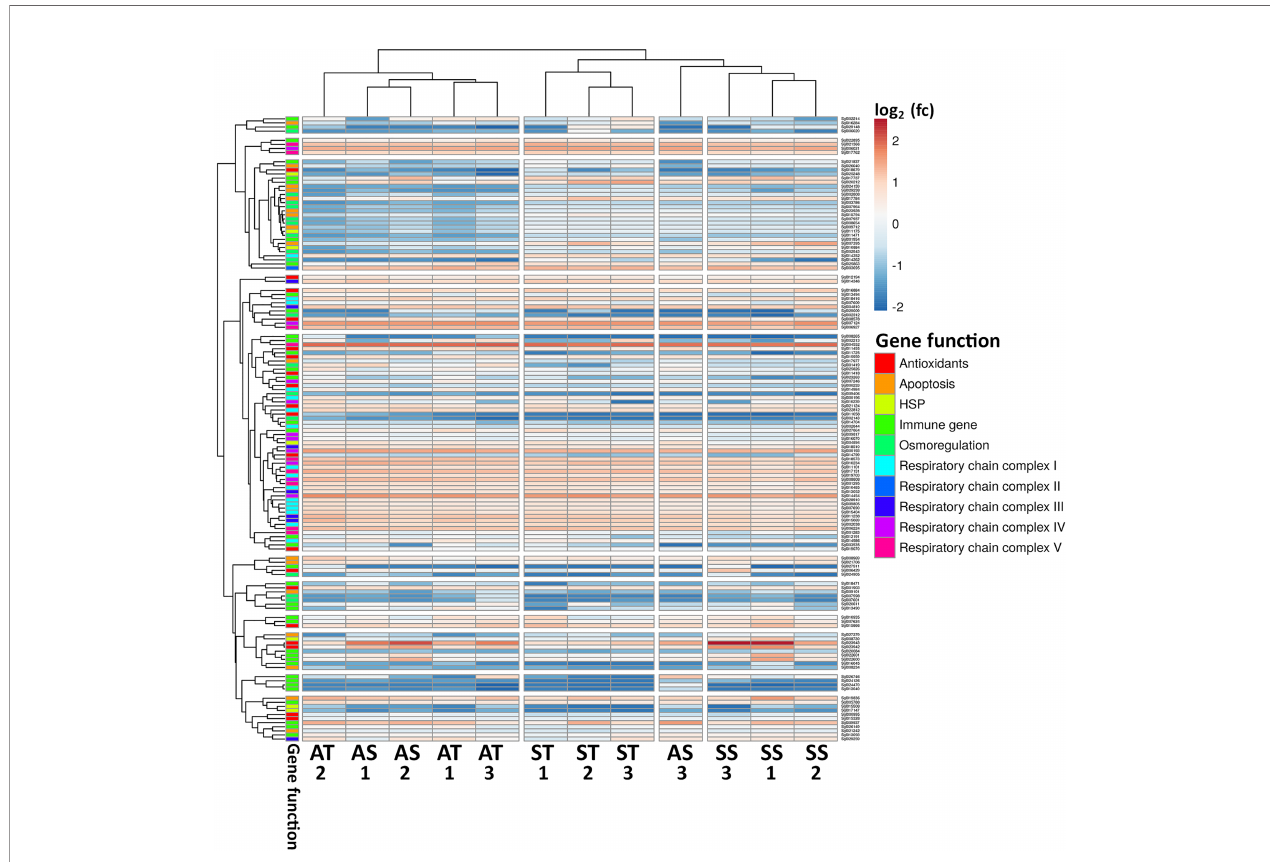
FIGURE 9 | Heatmap showing DGE of genes of interest in several relevant categories, colour coded within gene function. The colour of cells represents the log2 fold change (fc) expression value. Dendrograms of columns and rows show clustering based on average correlation. AS- Ambient condition and FSSW injected, AT- Ambient condition and TCAP injected, SS- Stressed and FSSW injected, ST- Stressed and TCAP injected. Numbers represent the biological replicates of each group (1 –